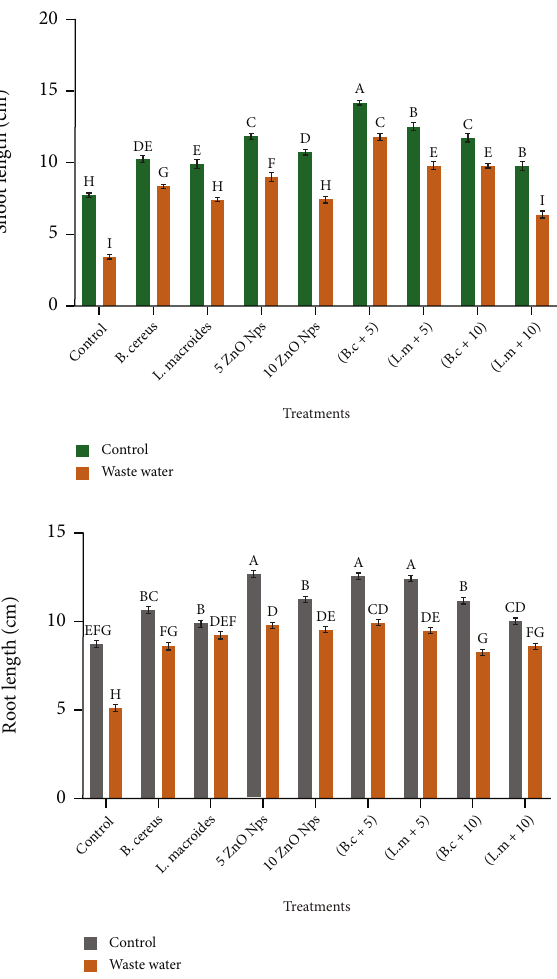
Figure 2: Synergistic e ff ect of bacteria strain Bacillus cereus and Lysinibacillus macroides and ZnO NP (5 mg/L and 10 mg/L) treatments on shoot and root length of rice grown in heavy metal-contaminated water. Error bars showed means of standard error ( ± SE) of three replicates ( n = 3 ) followed by di ff erent alphabetic letters showing statistical signi fi cance at 5% probability level. Control (distilled water), B.C+5 ( Bacillus cereus +5mg/L ZnO NPs), L.M+5 ( Lysinibacillus macroides +5 mg/L ZnO NPs), B.C+10 ( Bacillus cereus +10mg/L ZnO NPs), and L.M+10 ( Lysinibacillus macroides +10mg/L ZnO